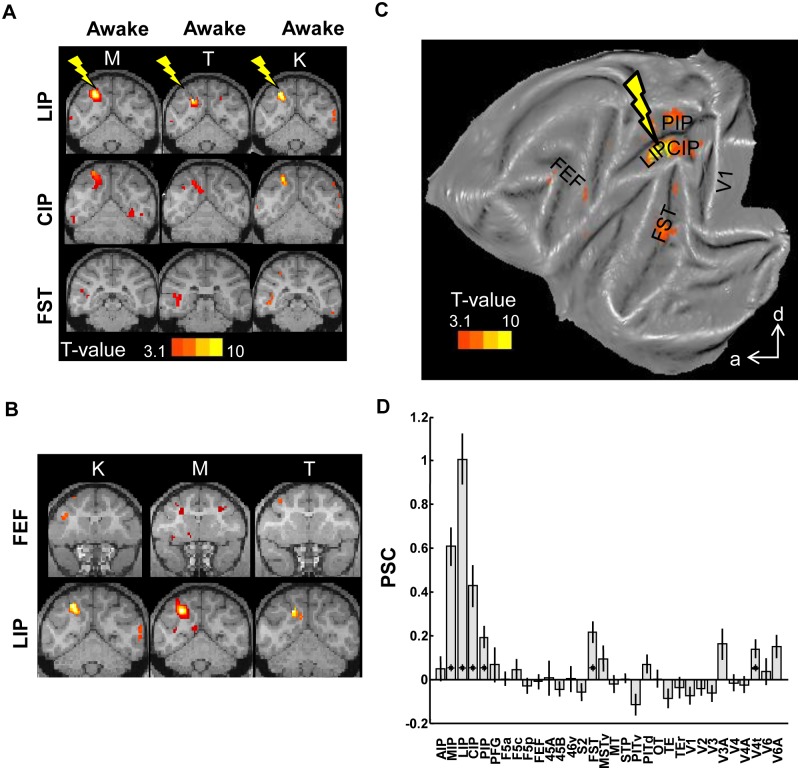
Microstimulation of area LIP.A. T-score maps for the contrast EM-NoEM, for individual animals, represented on coronal sections (template anatomy). See files LIP* in [25]. B. T-score maps for the contrast EM-NoEM, data from individual sessions, showing EM-induced FEF activations. C. T-score maps for the contrast EM-NoEM, group data, represented on a flat map. a: anterior; d: dorsal. D. Percent signal change * p < 0.05; corrected for multiple comparisons (32 ROIs). Black lines indicate standard error of the mean.